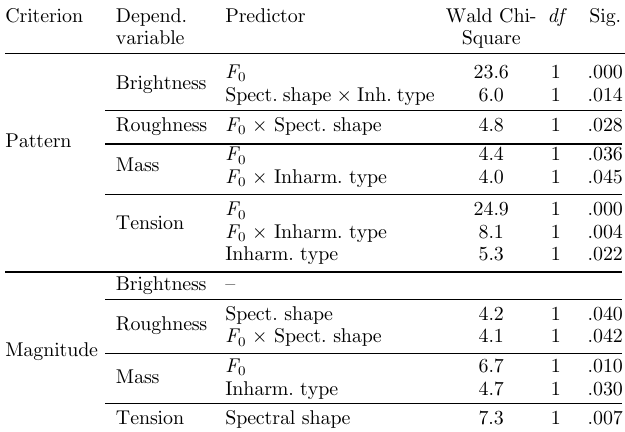
Table 2. Model effects for the generalised estimating equations models for repeated measures and multinomial distribution with the four qualities as dependent categorical variables and the acoustical conditions as predictors. Two different models were created for each quality incorporating categories based on the pro fi le pattern and the maximum magnitude